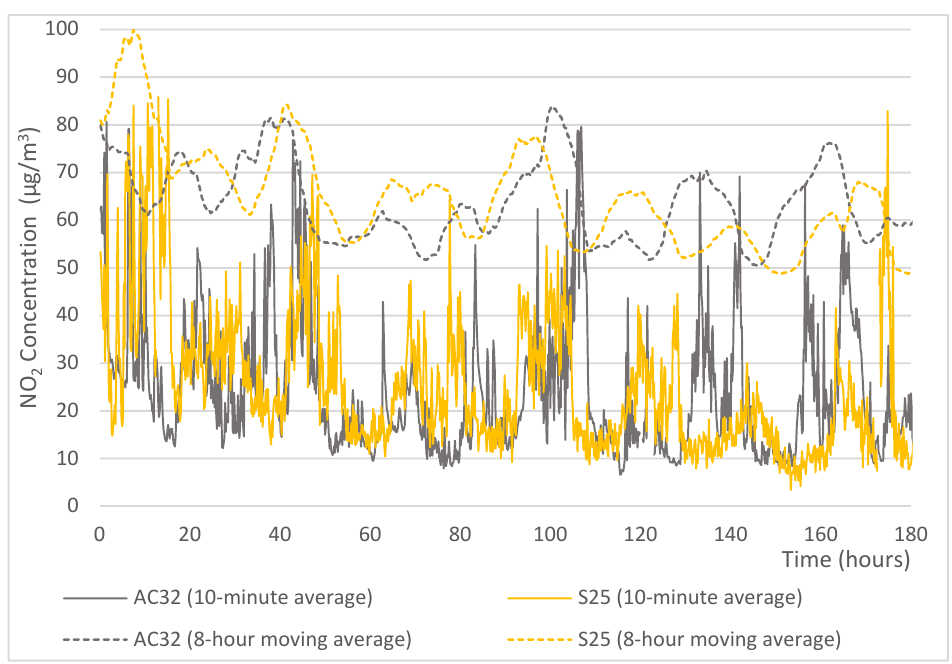
Figure 8. Comparison of reference (AC32) and sensor (S25) data for NO 2 over the 7-day measurement; moving average values are offset by 40 µg/m 3 .